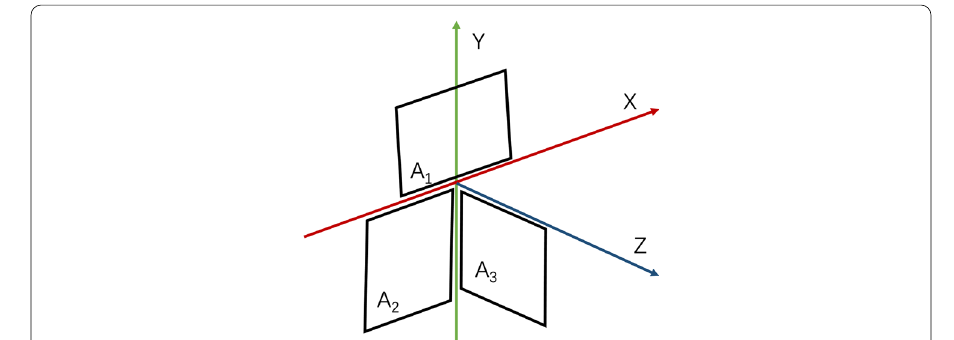
Fig. 1 Schematic diagram of antenna triaxial